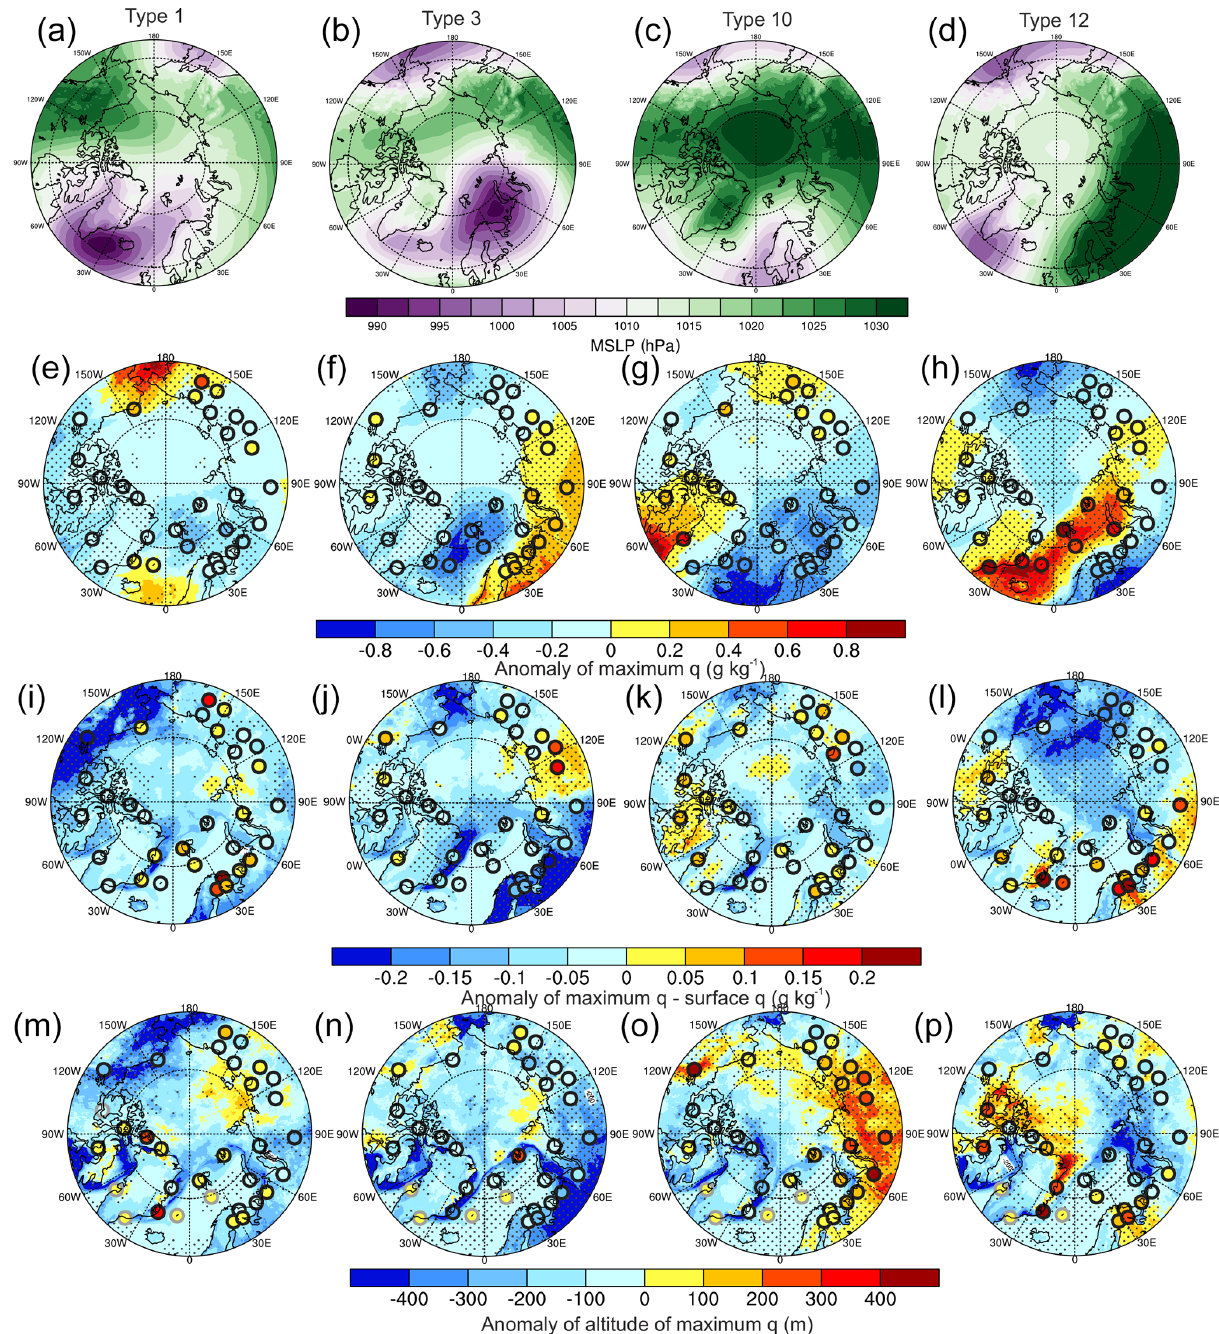
Figure 7. Mean sea level pressure (a–d) , anomaly of vertical maximum q (e–h) , anomaly of vertical maximum q − surface q (bulk inversion strength) (i–l) , anomaly of altitude of vertical maximum q (m–p) in four SOM circulation types (indicated on the top of the column) in December–February 2009–2018. The colours inside the circles show values based on radiosonde observations, whereas the fields are based on ERA5. The dotted shadings (ERA5) and black circles (radiosonde observations) show the anomalies that are different from zero at the 99% significance